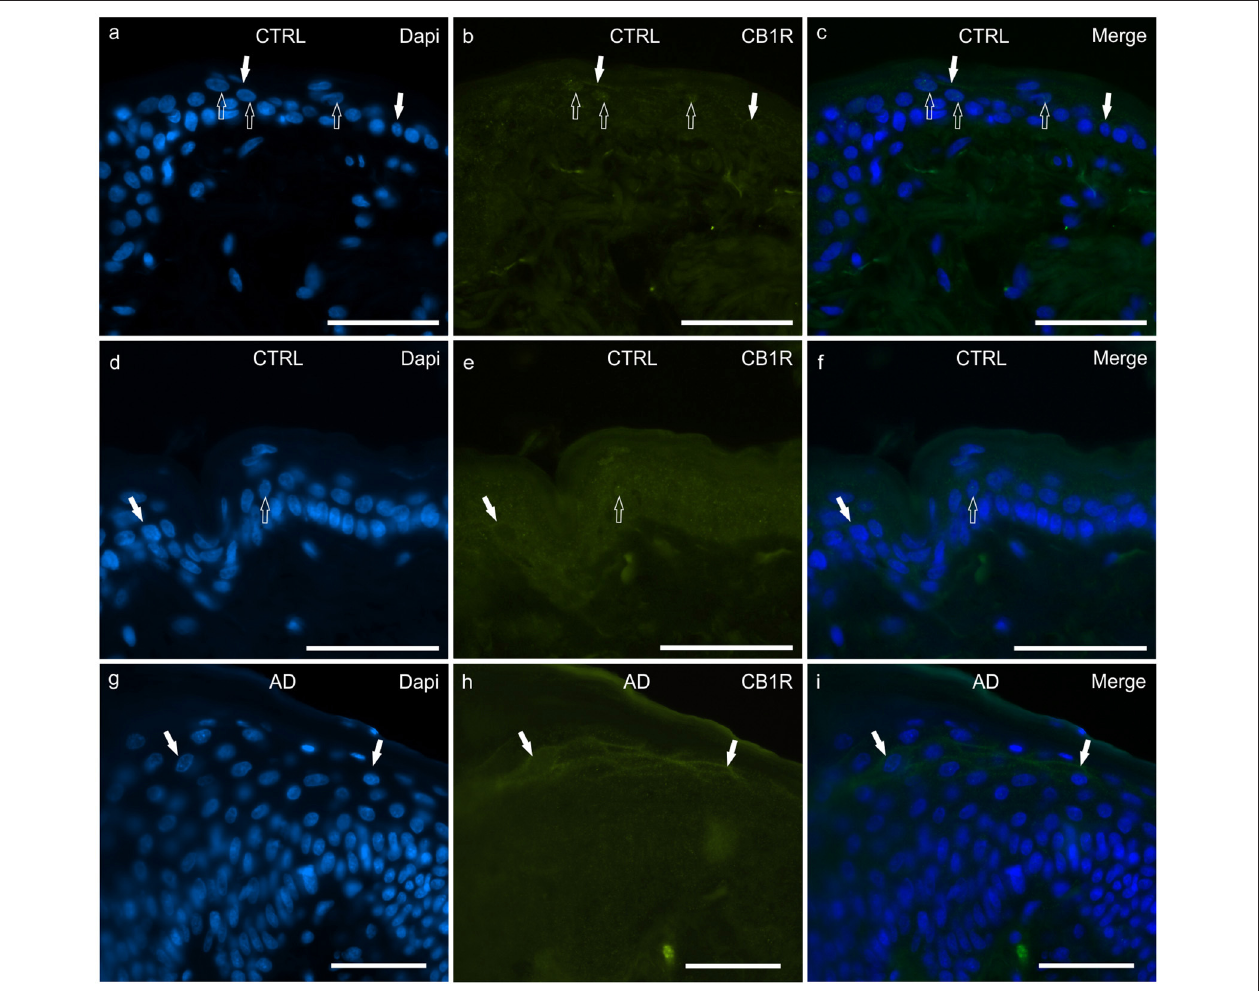
FIGURE 1 | Photomicrographs of cryosections of canine skin showing cannabinoid receptor 1 (CB1R) immunoreactivity (IR) in the tissues of the healthy dogs (CTRL) (a–f) and in the dogs with atopic dermatitis (AD) (g–i) . Two different anti-CB1R antibodies were used: (a–c) Rabbit anti CB1R (Orb10430) antibody; (d–f) Rabbit anti CB1R (ab23703) antibody. (a–f) The open arrows indicate DAPI-labeled nuclei of the epithelial cells which displayed faint CB1R-IR; the white arrows indicate faint CB1R-IR of the cell membrane of the keratinocytes. (g–i) In the AD-dogs, the keratinocytes of the upper layers (in proximity to the stratum corneum ) showed moderate CB1R-IR of their cell membranes (white arrows). (g–i) were obtained using the Orb10430 antibody. Bar, 50 µ